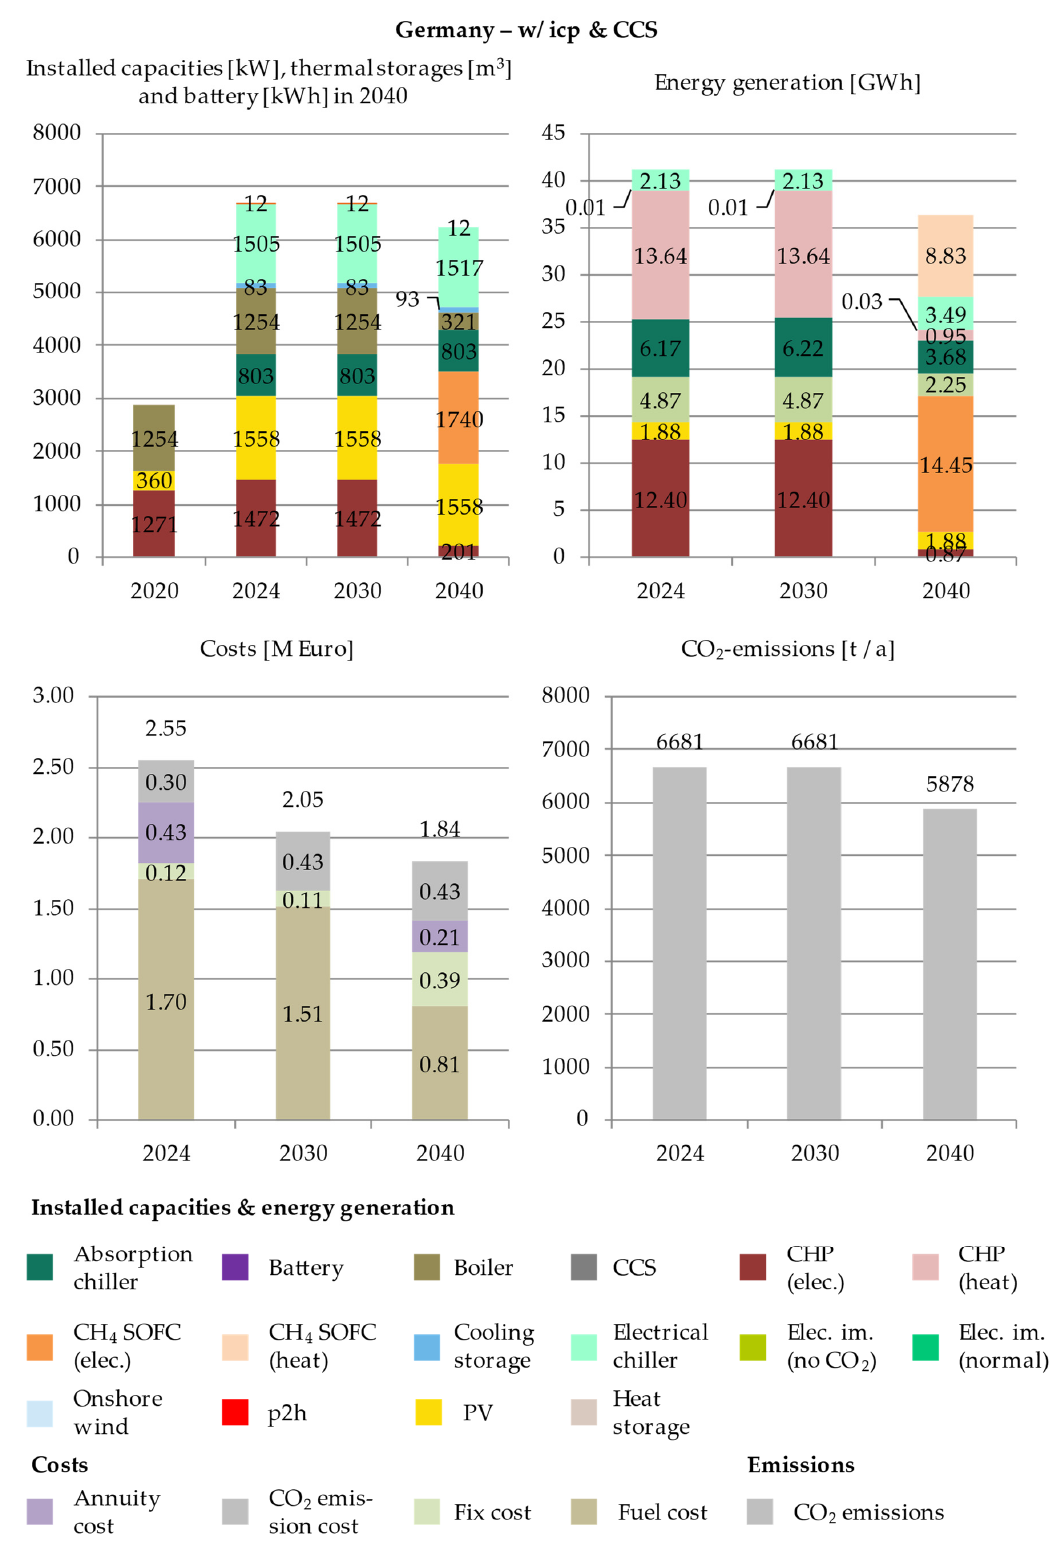
Figure A3. Detailed results for the German “w/ICP and CCS” scenario.